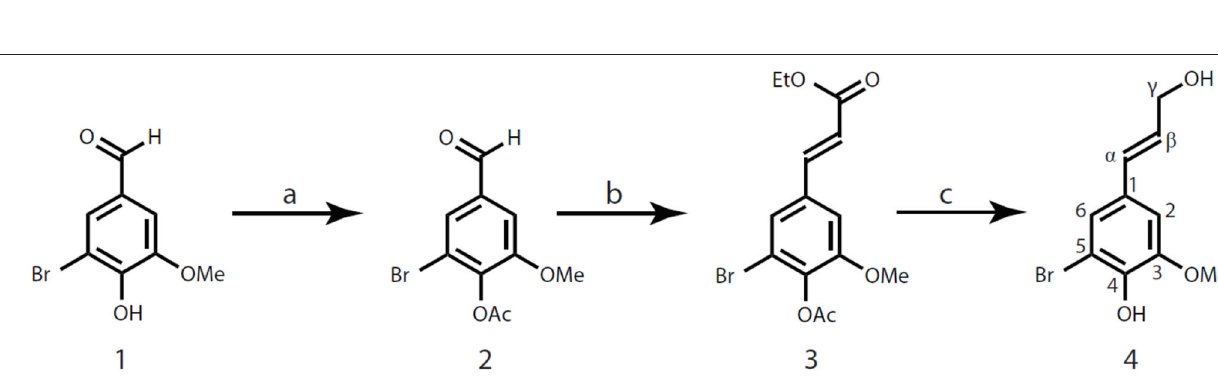
FIGURE 1 | Traditional pathways for synthesis of pinoresinol and syringaresinol.